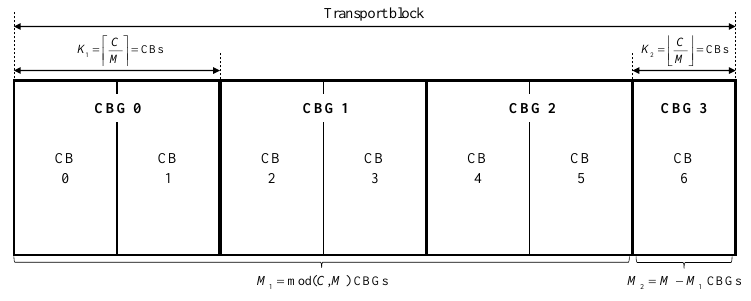
Figure 1. Grouping of CBG: Example for C = 7 and N =